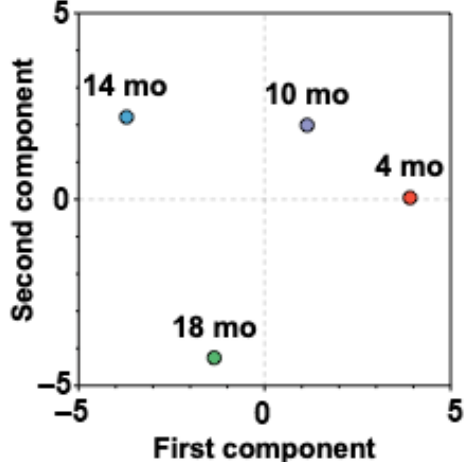
Figure 3. The principal component analysis (PCA) of three independent essential oil samples extracted from V. curassavica at different ages (4, 10, 14 and 18 months-age) via steam distillation on an industrial scale. The relative concentrations of the 19 identified compounds (detailed in Table 1) were used to perform the analysis.